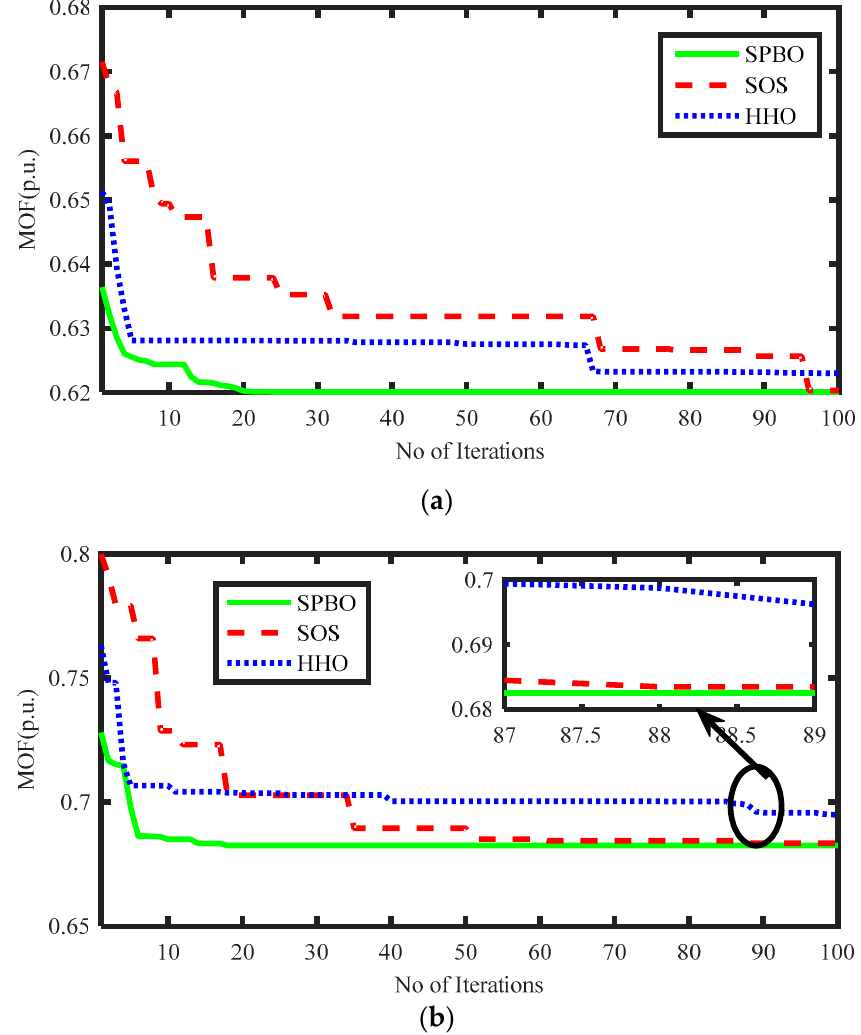
Figure 3. CC of optimization algorithms for case-2. ( a ) 33-bus test system; ( b ) 118-bus test system.